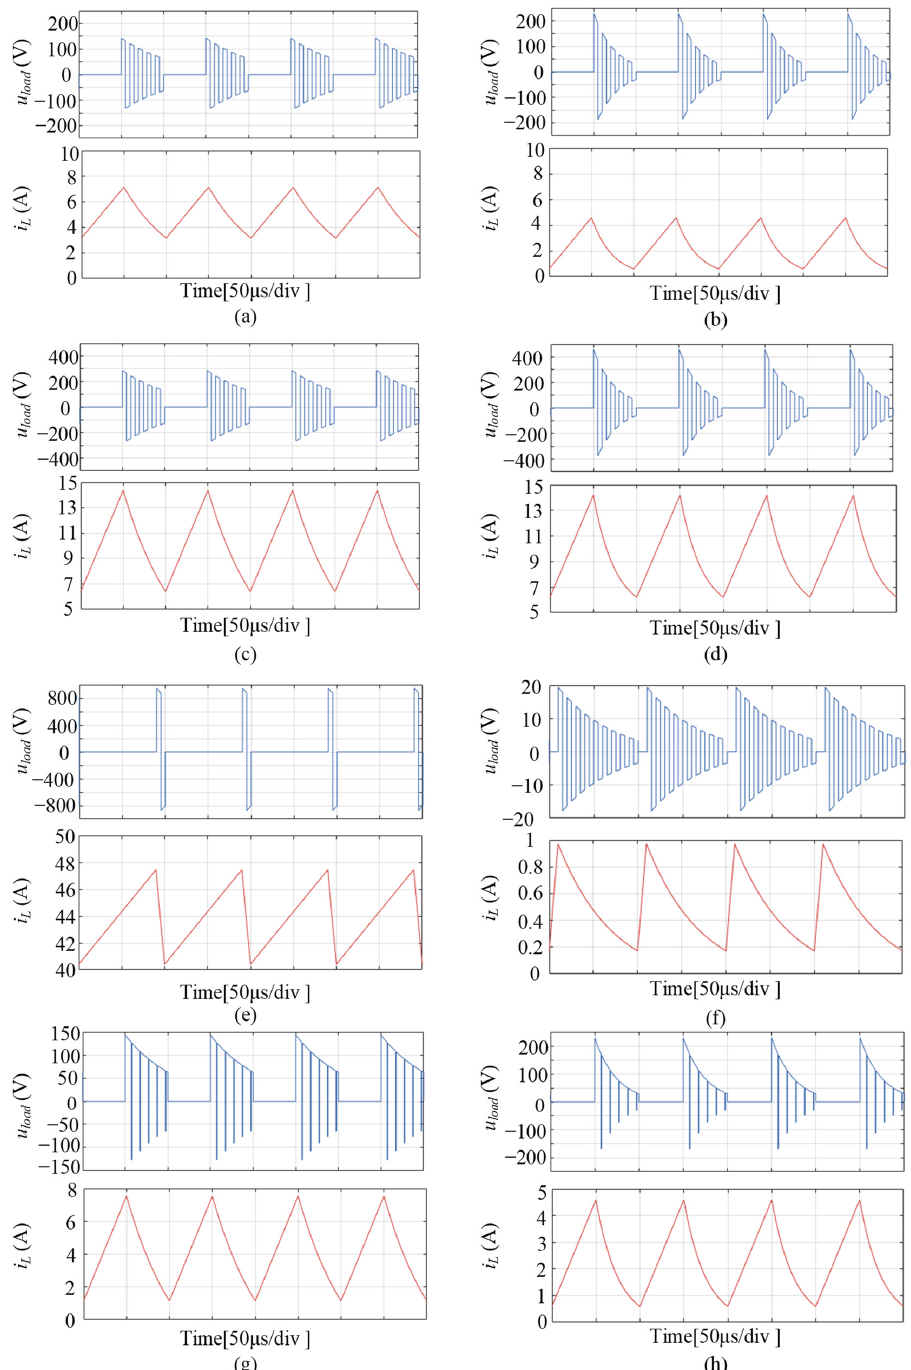
Figure 17. Simulation results: ( a ) U dc = 100 V, R load = 20 Ω , D = 0.5; ( b ) U dc = 100 V, R load = 50 Ω , Figure 18. Simulation results: ( a ) U dc = 100 V, R load = 20 Ω , D = 0.5; ( b ) U dc = 100 V, R load = 50 Ω , D = 0.5; ( c ) U dc = 200 V, R load = 20 Ω , D = 0.5; ( d ) U dc = 200 V, R load = 50 Ω , D = 0.5; ( e ) U dc = 100V, R load = 20 Ω , D D = 0.5; ( c ) U dc = 200 V, R load = 20 Ω , D = 0.5; ( d ) U dc = 200 V, R load = 50 Ω , D = 0.5; ( e ) U dc = 100V, = 0.9; ( f ) U dc = 100 V, R load = 20 Ω , D = 0.1. The reflex charging mode simulations: ( g ) U dc = 100 V, R load R load = 20 Ω , D = 0.9; ( f ) U dc = 100 V, R load = 20 Ω , D = 0.1. The reflex charging mode simulations: = 20 Ω , D = 0.5 and ( h ) U dc = 100 V, R load = 50 Ω , D = 0.5. ( g ) U dc = 100 V, R load = 20 Ω , D = 0.5 and ( h ) U dc = 100 V, R load = 50 Ω , D =